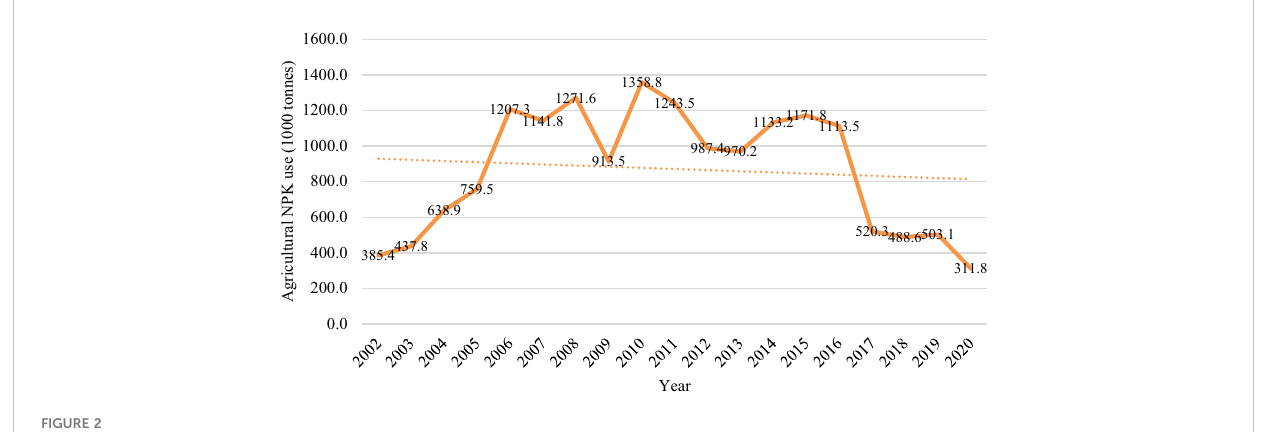
FIGURE 2 Total agricultural use of NPK in Africa. Source: FAO database;